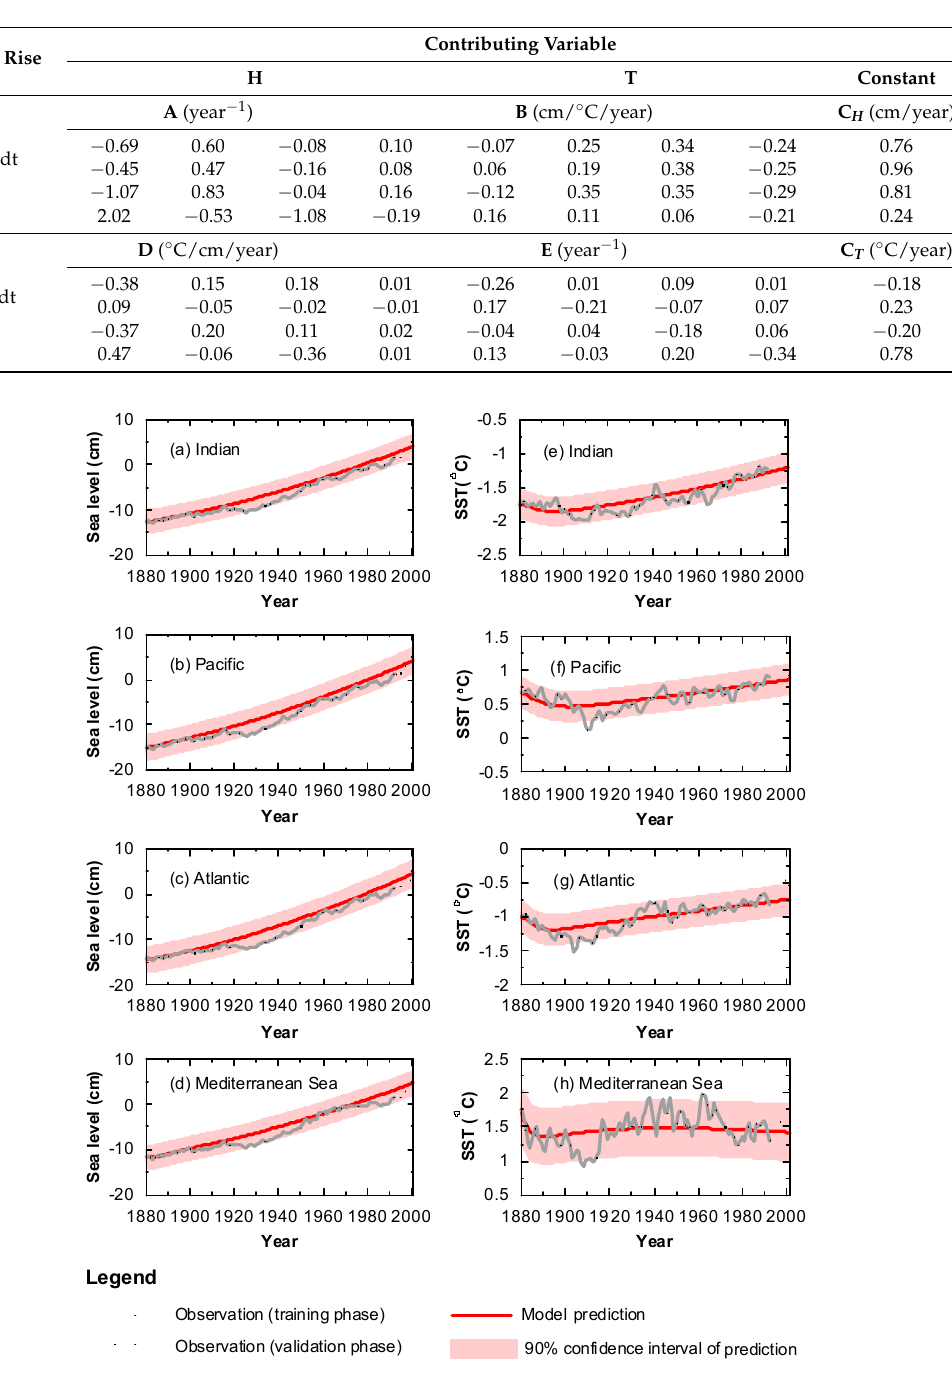
Table 1. Four Region Model coefficient matrices.